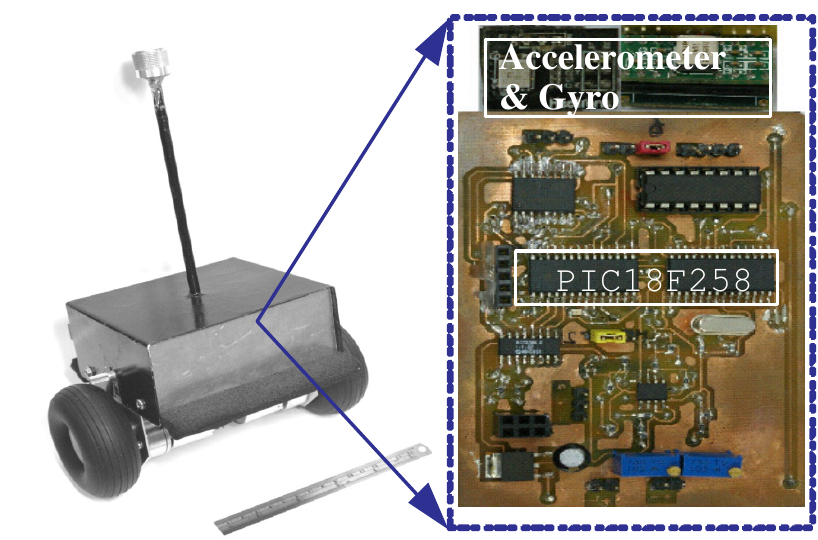
Figure 13. Onboard computer module of the two-wheel vehicle